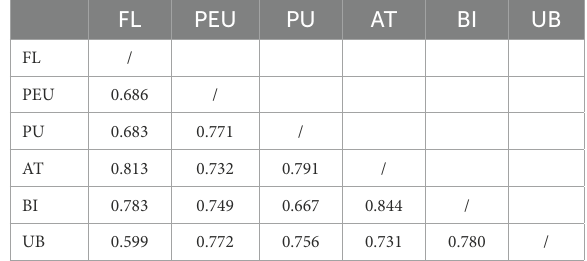
TABLE 10 Results of Heterotrait-monotrait